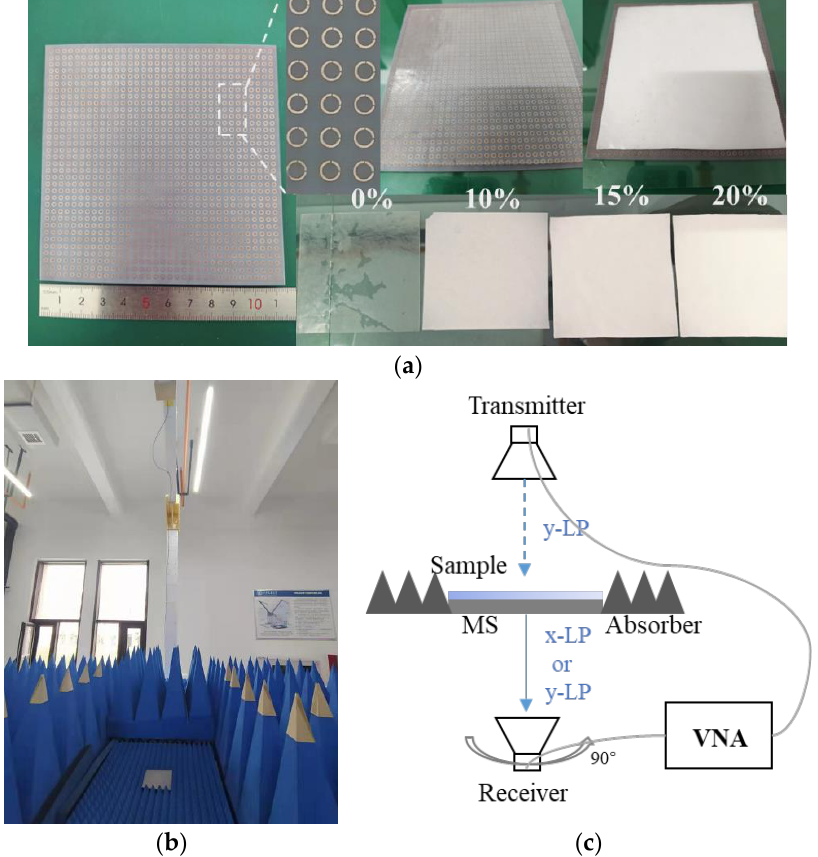
Figure 5. ( a ) Meta-surface prototype and dielectric films made of PDMS and BTO with volume frac- tions of 0%, 10%, 15%, and 20%. ( b ) The measurement setup and ( c ) its schematic illustration.